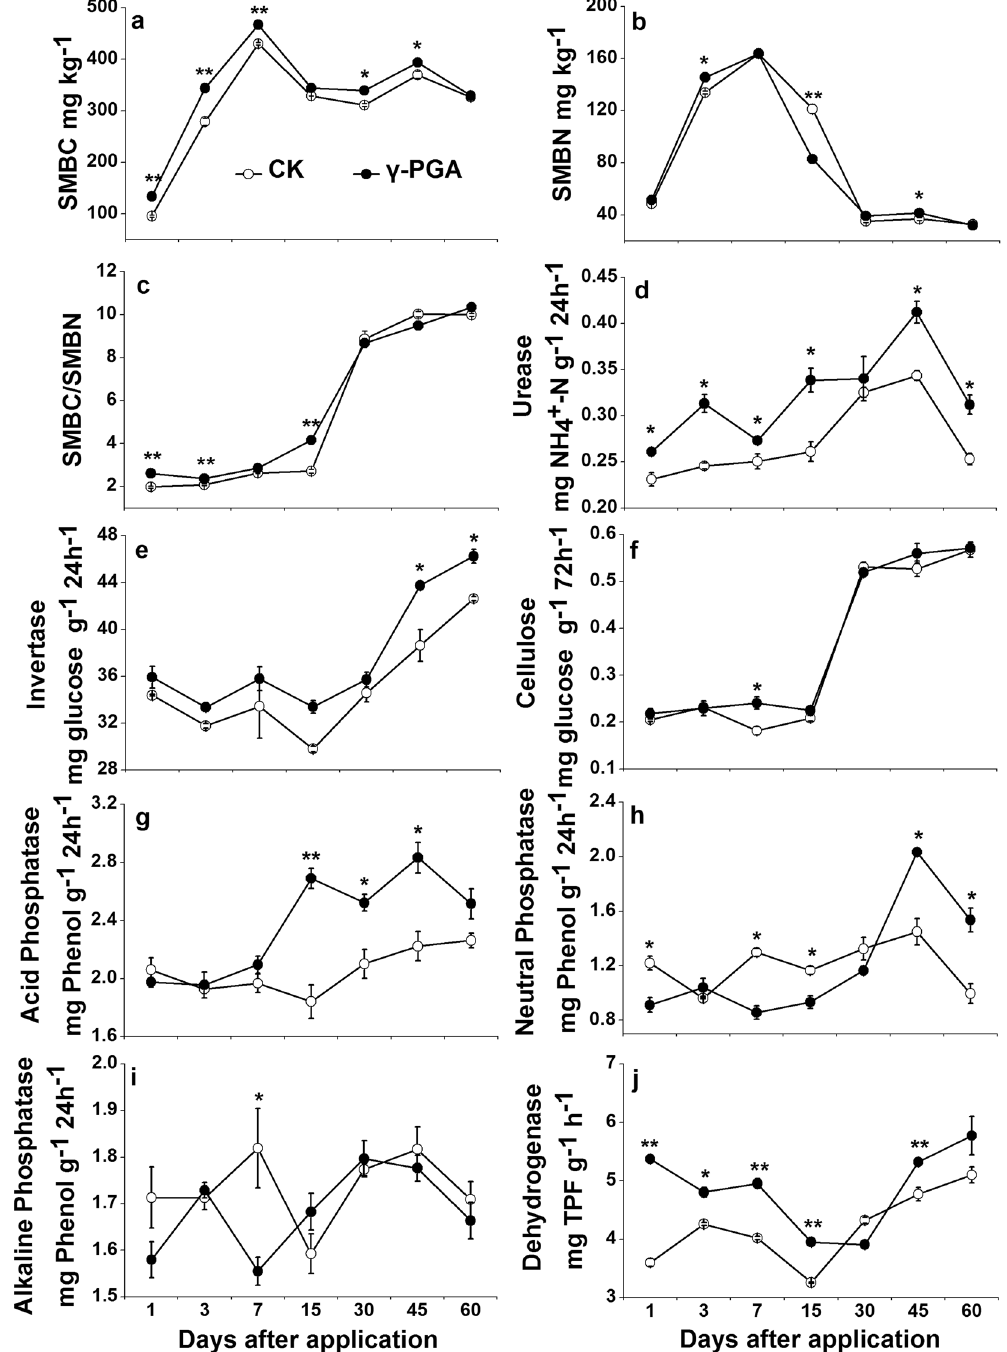
Figure 4. Temporal variations of soil microbial carbon (SMBC, a ), soil microbial nitrogen (SMBN, b ), SMBC/ SMBN ( c ), soil urease ( d ), soil invertase ( e ), soil cellulose ( f ), soil acid phosphatase ( g ), soil neutral phosphatase ( h ), soil alkaline phosphatase ( i ) and soil dehydrogenase ( j ). Error bars represent standard error (n = 3). CK: Normal fertilization with no γ -PGA application, γ -PGA: Normal fertilization with application of 350.44 mg γ -PGA kg − 1 soil. ** p < 0.01, * p <